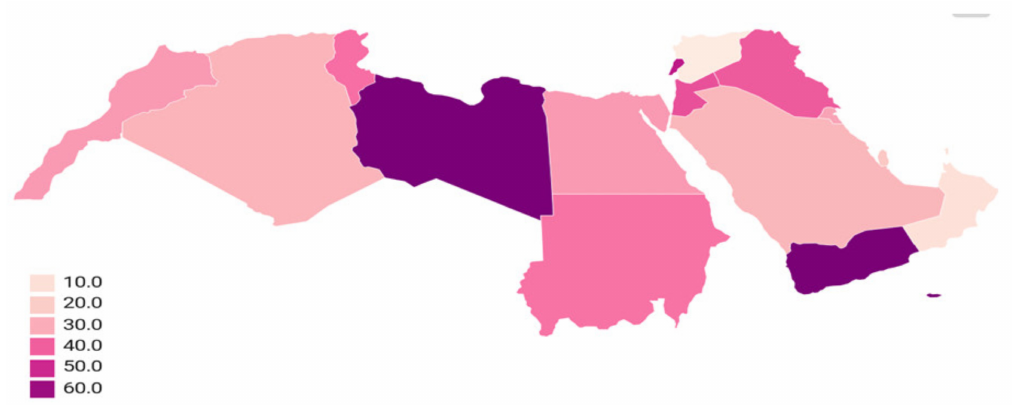
Figure 4. Geography distribution of ESBL among E. coli and ESKAPE pathogens in the Arab region (mean percentage) during 2000–2020.